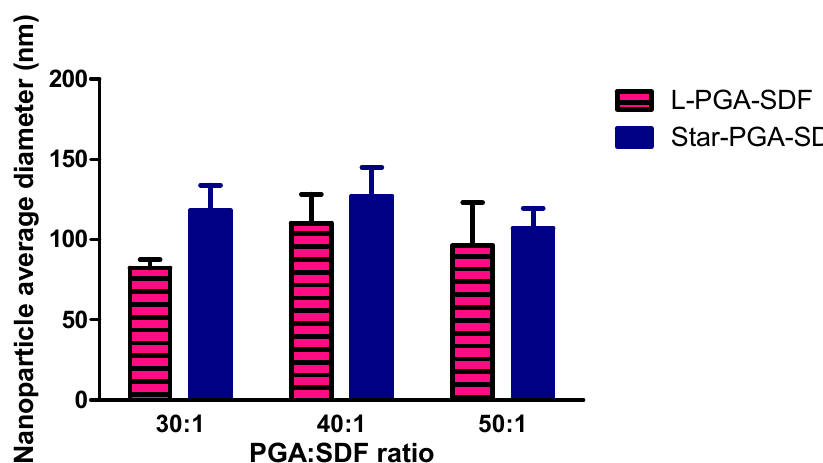
Figure 4. Nanoparticle average diameter of L-poly(glutamic acid) (PGA)—Stromal-Derived Factor 1 α (SDF) and star-PGA–SDF formulations at molar ratios of 30:1, 40:1 and 50:1 measured using nanoparticle tracking analysis ( n = 3). No significant difference between the average diameter of L-PGA–SDF and star-PGA–SDF formulations at any given ratio.